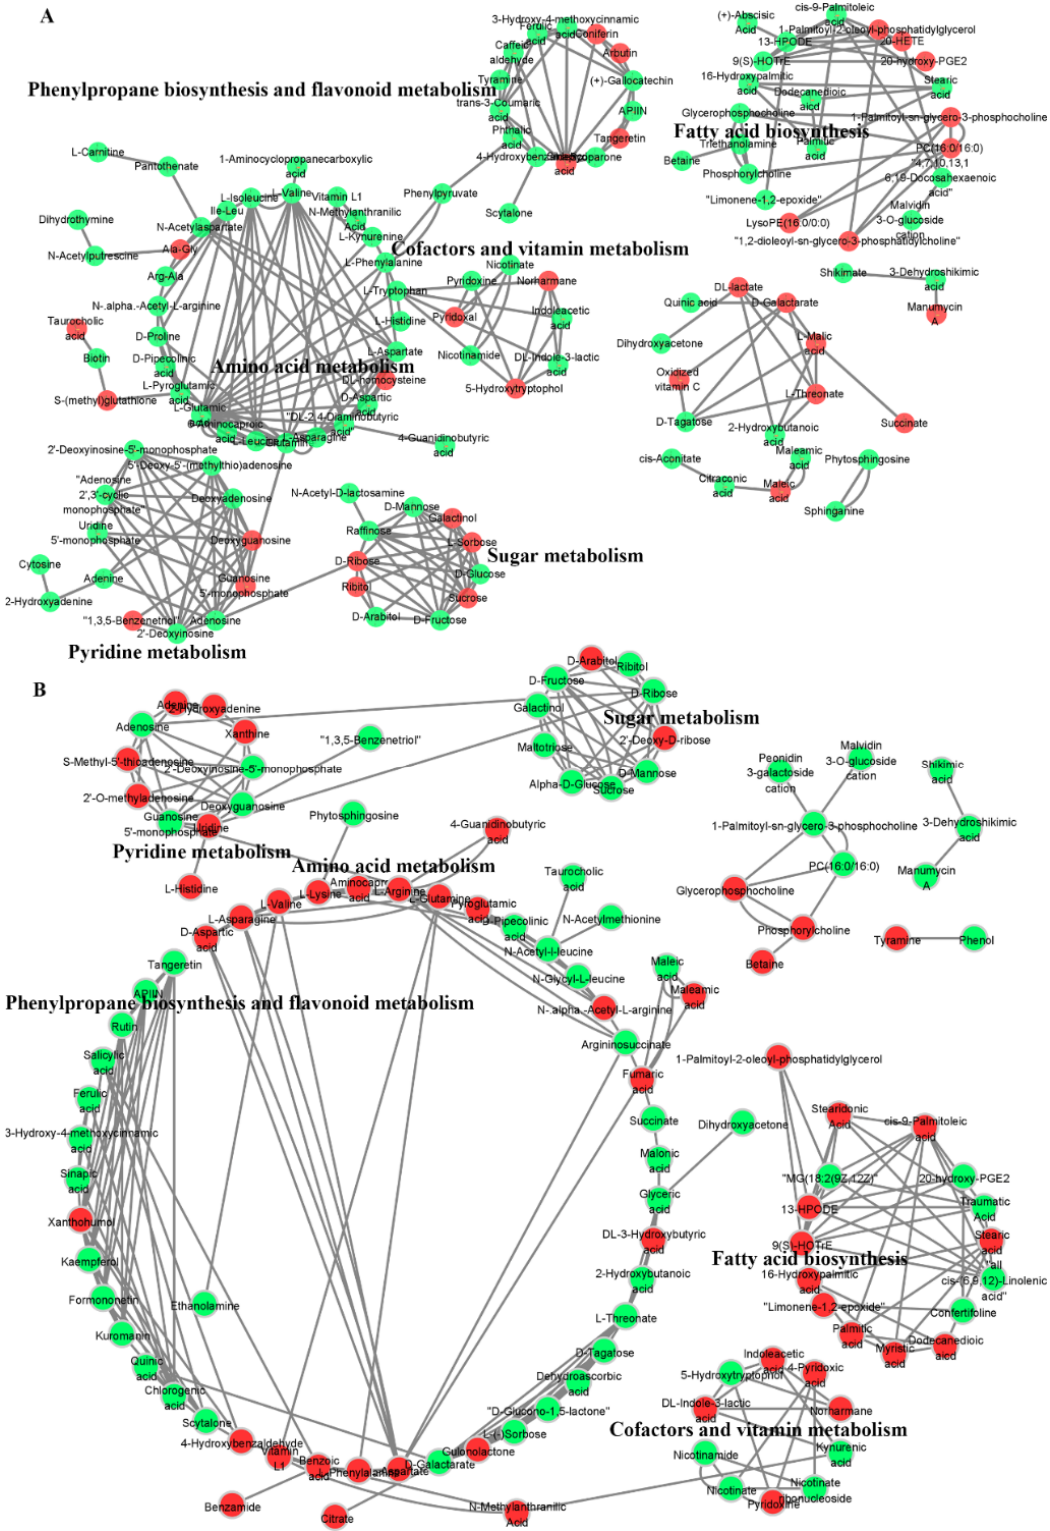
Figure 8. The metabolite–metabolite interaction network of significantly different metabolites that participated in KEGG in rice subjected to the TLS ( A ) and TS ( B ) experiments was developed using the cytoscape software. Red represents increased metabolites (SP2 VS CK) and green represents decreased metabolites (SP2 VS CK).